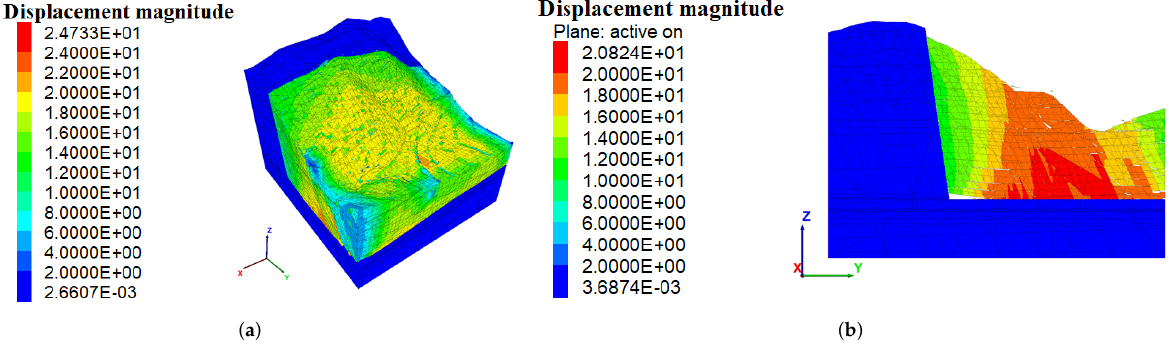
Figure 11. The Z-direction displacement after excavating 9# and 10# coal seams. ( a ) Overview, ( b )